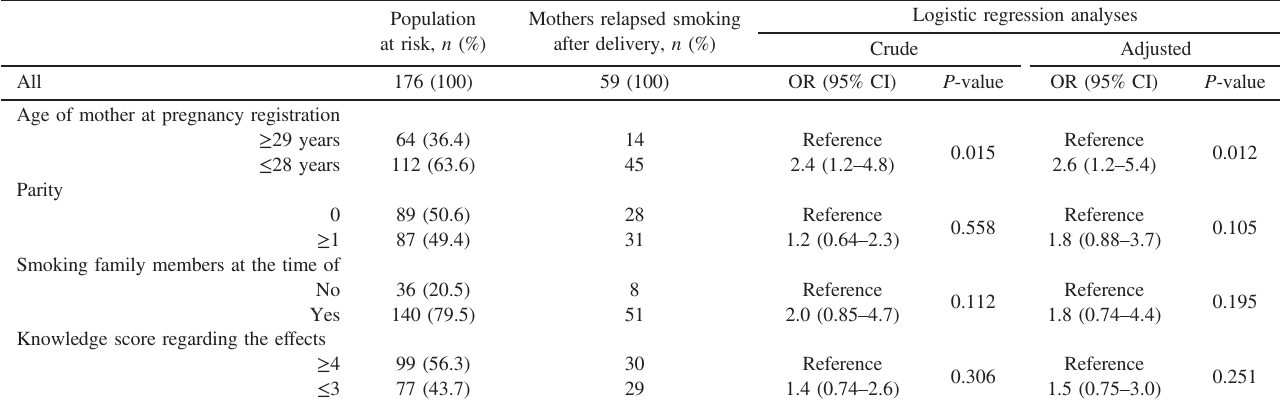
Logistic regression